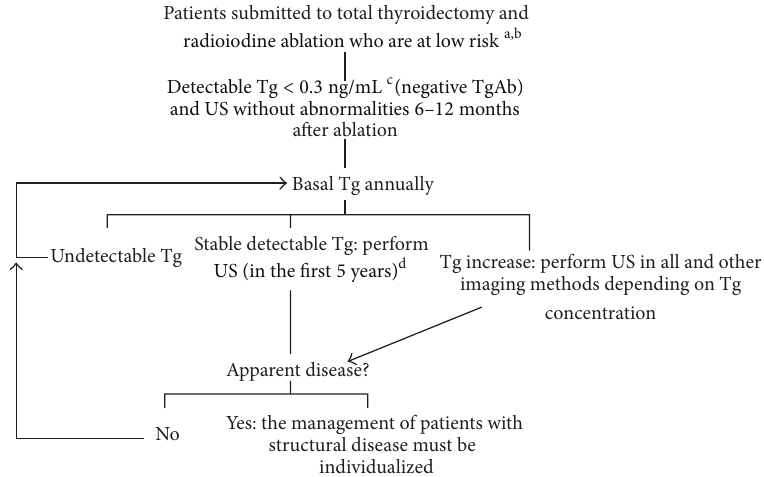
Figure 1: Follow-up proposal for low-risk patients with detectable Tg < 0.3 ng/mL, negative circulating TgAb, and negative US after ablation. Tg, thyroglobulin; TgAb, anti-thyroglobulin antibodies; US, neck ultrasound. a The algorithm does not apply to patients not submitted to ablation. b Low risk defined according to currently recommended classifications [3, 8]. c Considering a second-generation assay with a functional sensitivity of 0.1 ng/mL. d After 5 years of stable detectable Tg and negative US, follow-up can be performed exclusively by annual measurement of basal Tg and imaging methods are only needed in the case of an